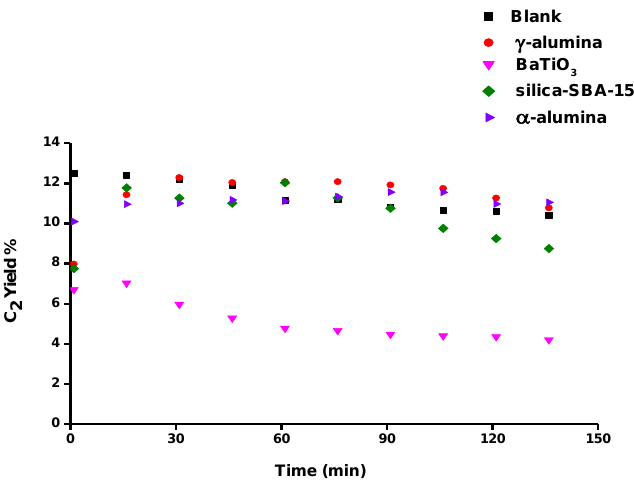
Figure 6. Yield of C 2 products as a function of time for different packing materials.